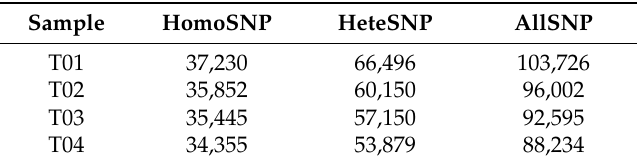
Table 6. SNP distribution.